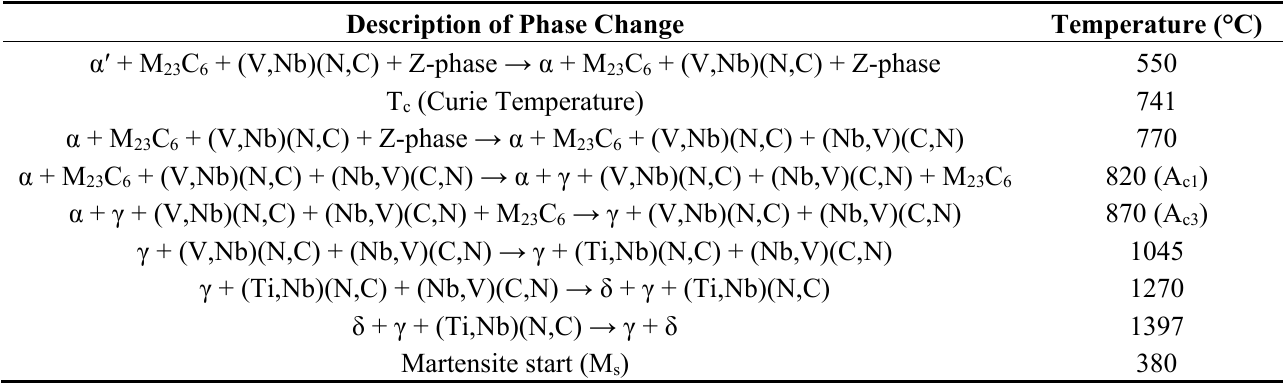
Figure 5. Differential scanning calorimetric plot of as-received Grade 91 steel. Table 2. Various transformation temperatures of Grade 91